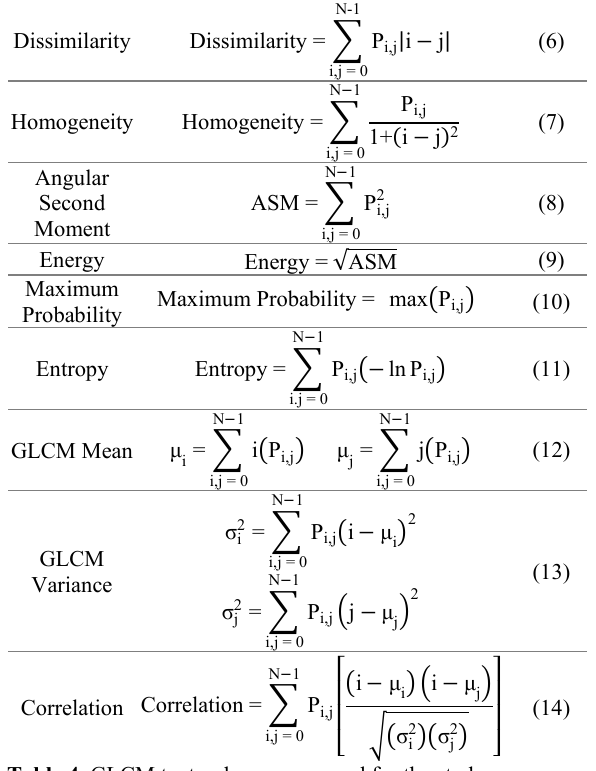
Table 4. GLCM textural measures used for the study